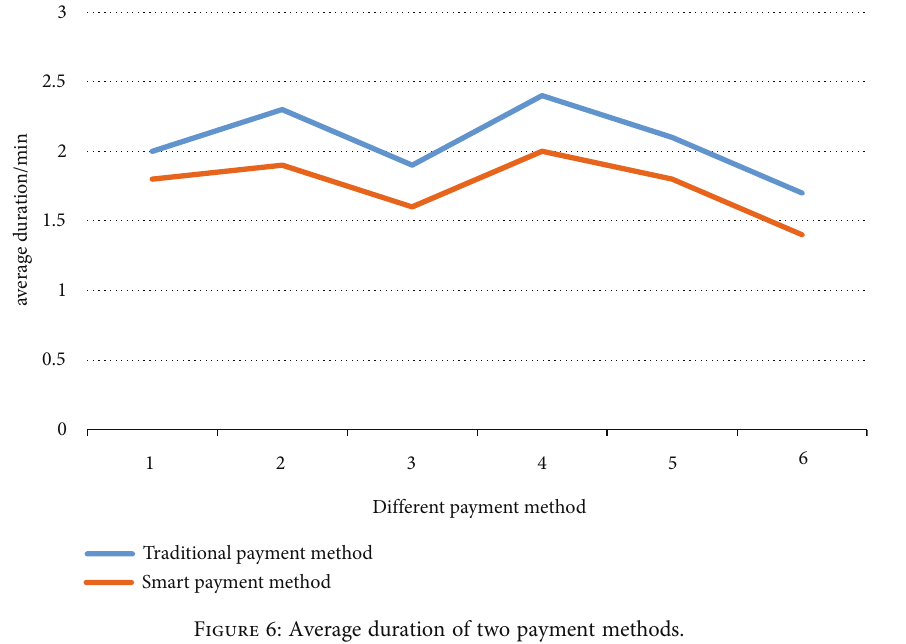
Figure 6: Average duration of two payment methods.